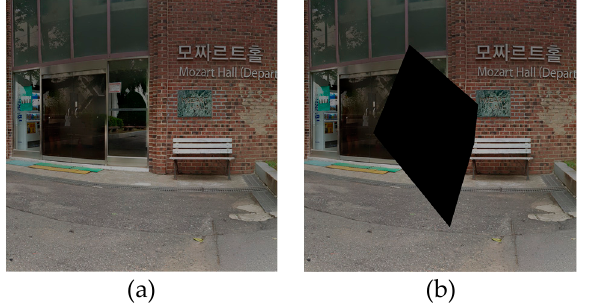
Figure 9. ERP images including holes and the concealed regions, where the holes are concealed by the proposed algorithm.